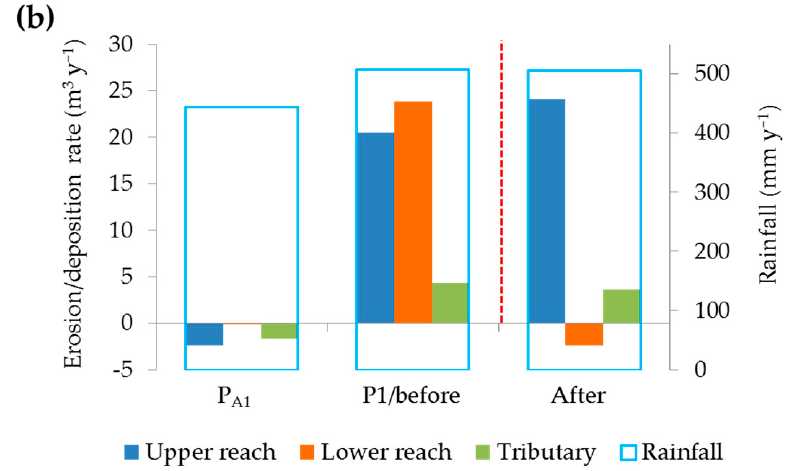
Figure 3. ( a ) Net erosion/deposition rate registered at the different reaches by period and ( b ) net erosion/deposition rate recorded before and after the establishment of the restoration measures. Period P A1 (from December 2001 to June 2007) refers to the data obtained by Gómez-Gutiérrez et al. [7] , who surveyed 28 fixed topographic cross sections. The vertical red line indicates the establishment of the restoration measures.